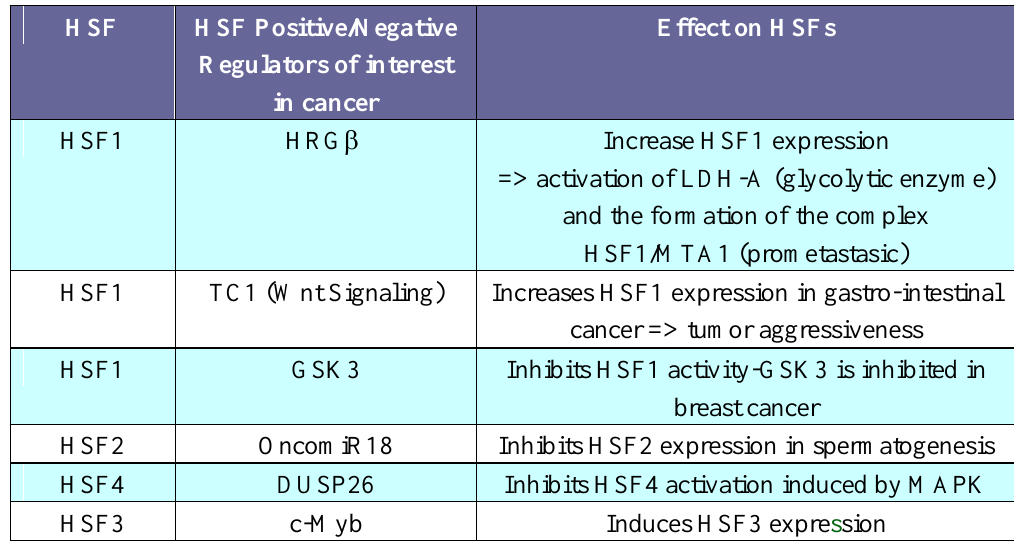
Table 2. HSF regulation in